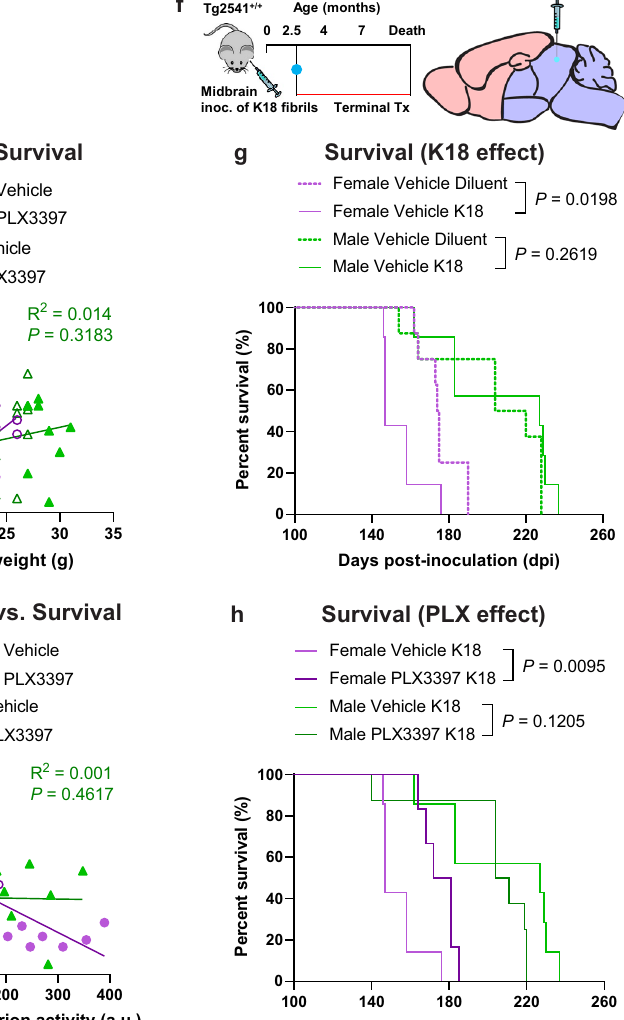
terminal PLX3397 treatment of Tg2541 mice from 2.5 mo of age until death, fol- lowing inoculation of K18 tau fi brils into the midbrain (hindbrain region) at 2.5 mo of age. g Kaplan – Meier plot showing percent survival of female or male Tg2541 mice inoculated with K18 tau fi brils or diluent. n =8 mice for Female Vehicle Dilu- ent; n =7 mice for Female Vehicle K18; n =8 mice for Male Vehicle Diluent; n =7 mice for Male Vehicle K18. Differences in survival between diluent and K18 inocu- lation in male or female mice treated with vehicle were evaluated by Log-rank (Mantel-Cox)test. h Kaplan – Meierplotshowing percentsurvivaloffemaleormale Tg2541 mice inoculated with K18 tau fi brils and then receiving terminal treatment of vehicle or PLX3397 (275mg/kg oral). n =7 mice for Female Vehicle K18; n =6 mice for Female PLX3397 K18; n =7 mice for Male Vehicle K18; n =8 mice for Male PLX3397 K18. In ( b , g , and h ), differences in survival between treatment groups wereevaluatedbyLog-rank(Mantel-Cox)test.SourcedataareprovidedasaSource Data fi